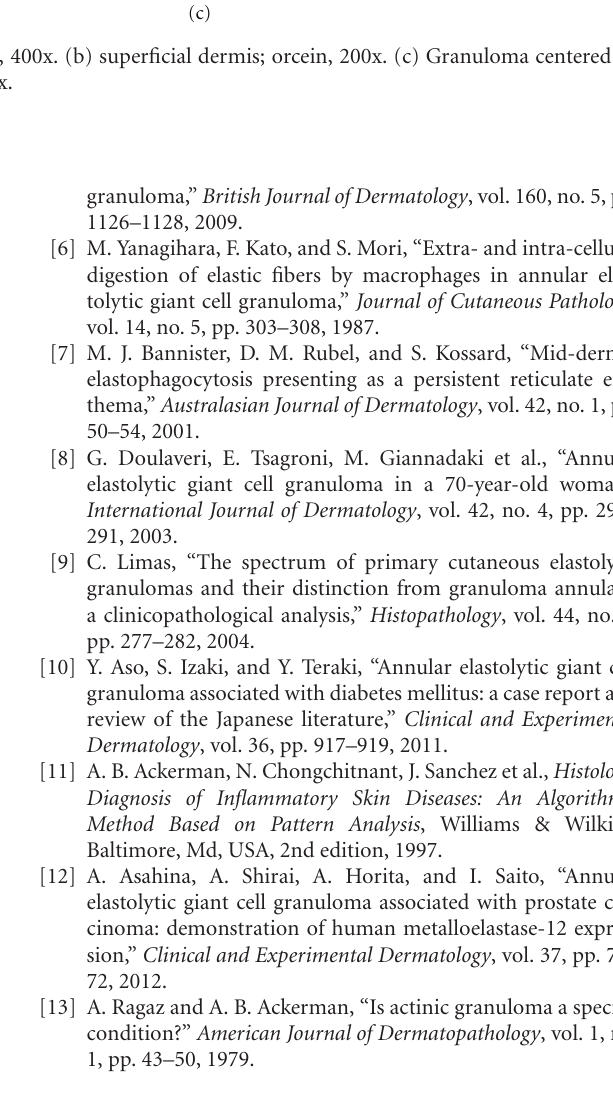
Figure 3: (a) Fragmentation of elastic fibers in the giant cell; H&E, 400x. (b) superficial dermis; orcein, 200x. (c) Granuloma centered by necrobiosis and multinucleate giant cells with palisading; H&E, 100x.